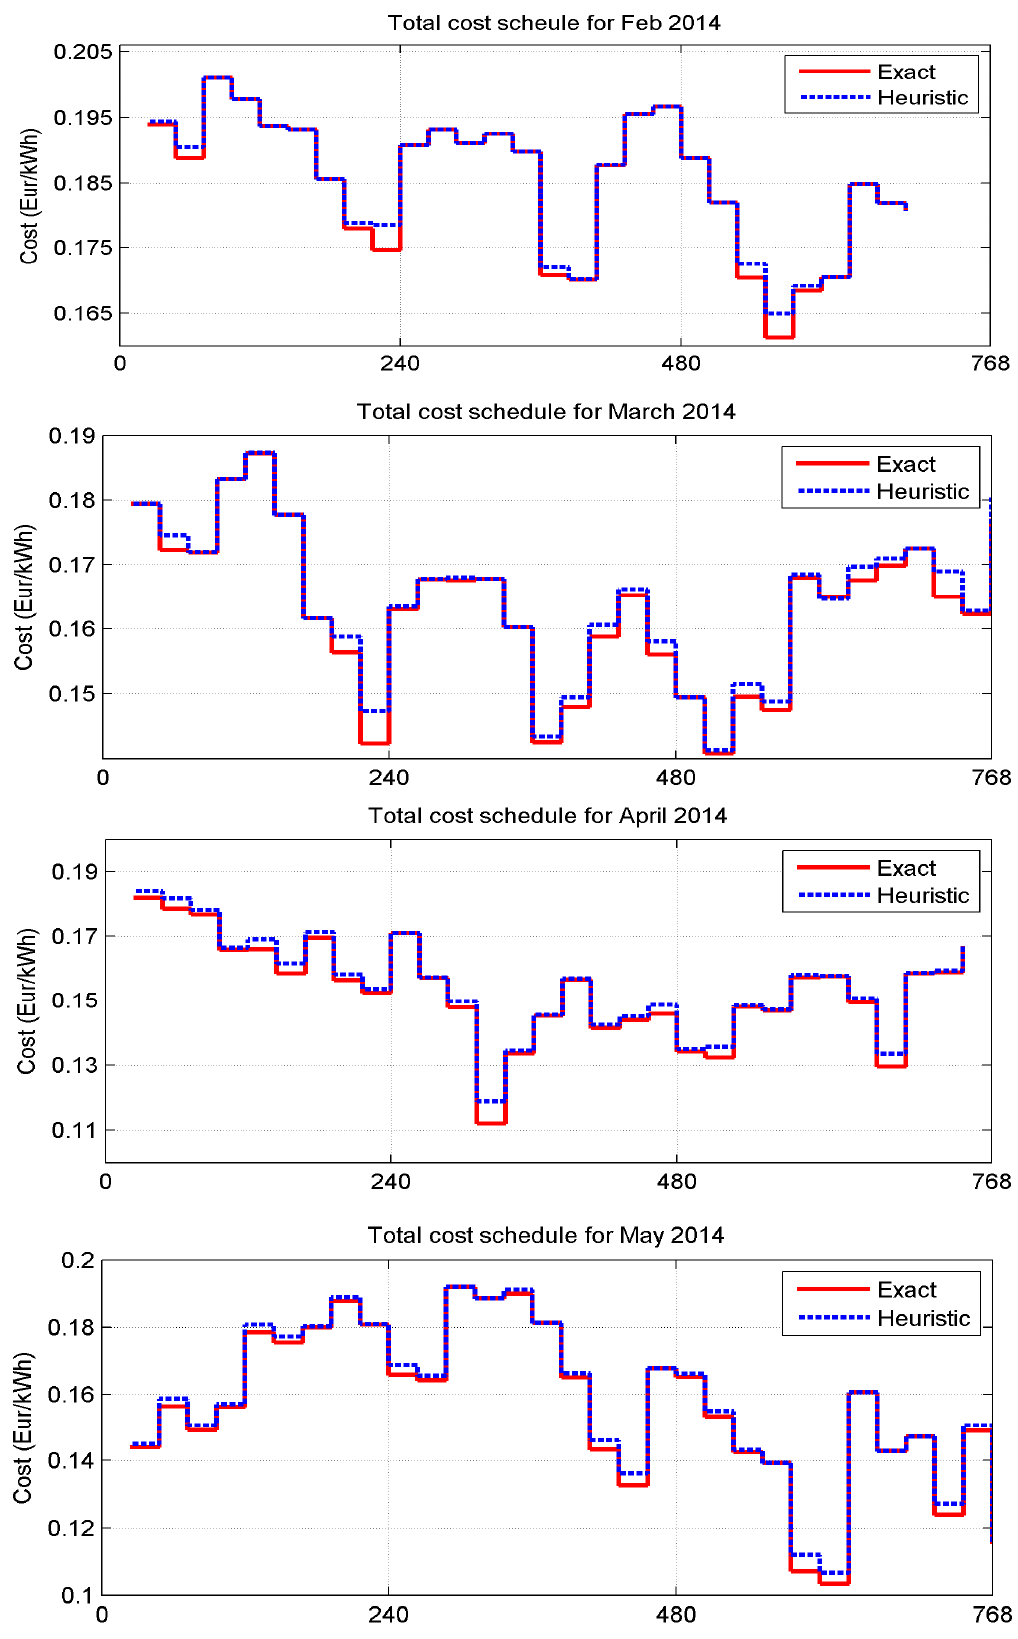
Figure 4. Cont Figure 4. Cont .